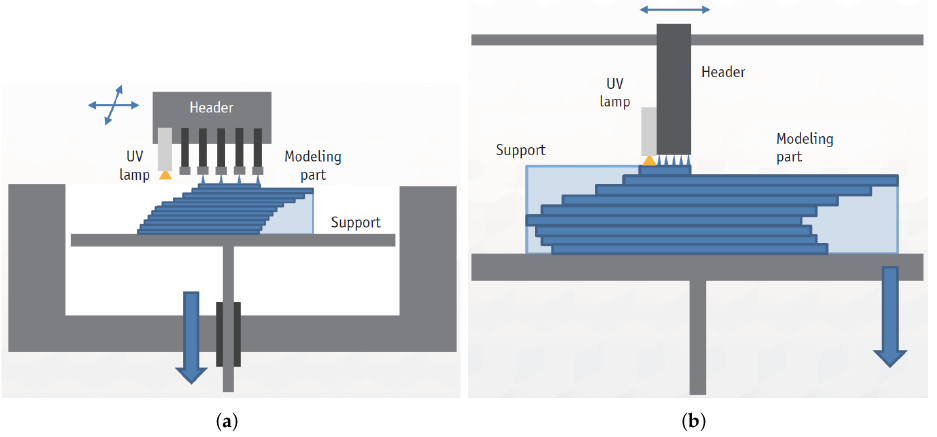
Figure 9. Examples of Polyjet and Multijet printers printing: ( a ) Polyjet and ( b ) Multijet. (Reprinted images from Korean Journal of Radiology , Volume 17, Kim, Guk Bae and Lee, Sangwook and Kim, Haekang and Yang, Dong Hyun and Kim, Young-Hak and Kyung, Yoon Soo and Kim, Choung-Soo and Choi, Se Hoon and Kim, Bum Joon and Ha, Hojin and others, Three-Dimensional Printing: Basic Principles and Applications in Medicine and Radiology, 182–197, Copyright (2016), with permission from The Korean Society of Radiology under the terms of the Creative Commons Attribution Non-Commercial License: http://creativecommons.org/licenses/by-nc/3.0, accessed on 15 November